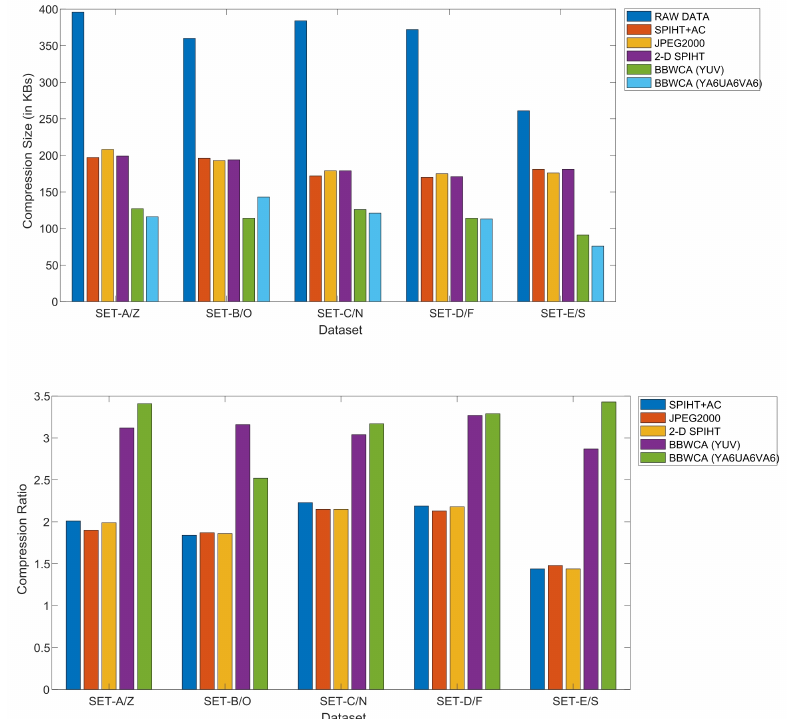
Figure 10. Comparative analysis of compression size and ratios for lossless compression of EEG data (size in